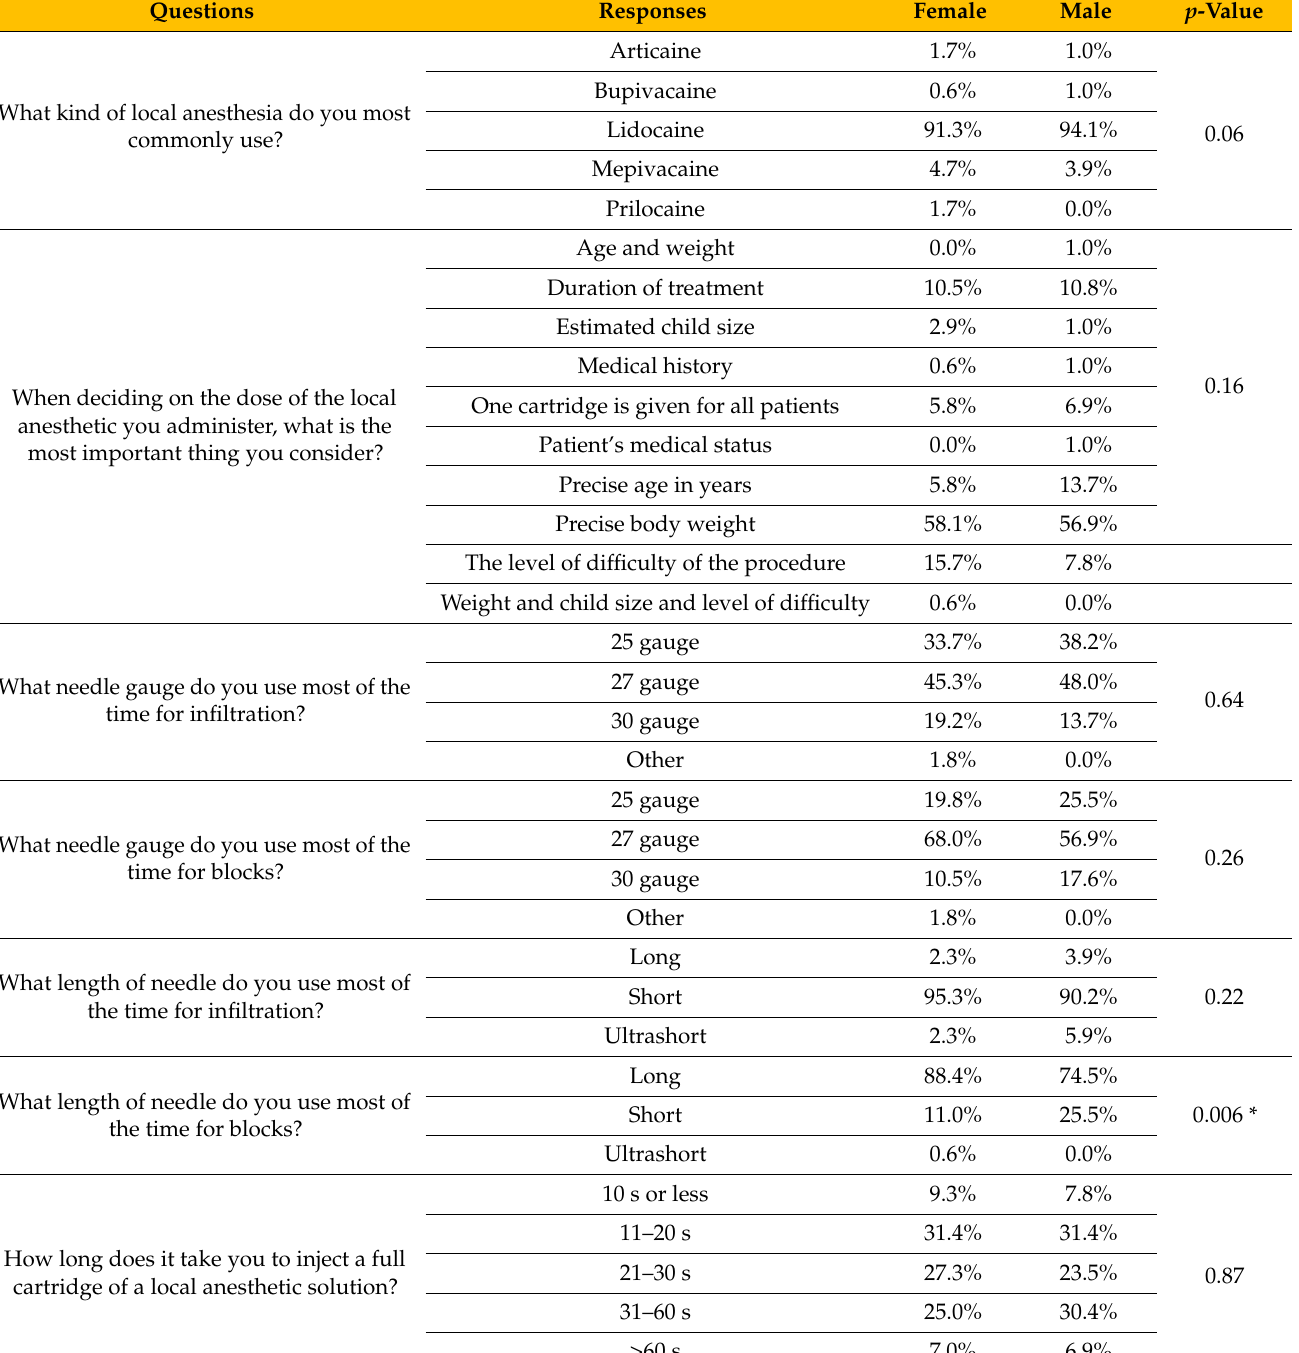
Table 2. Perceptions of local anesthetics among dental practitioners based on